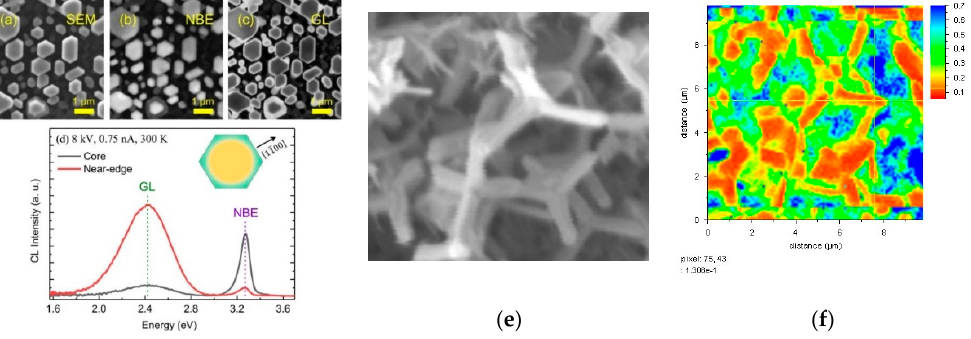
Figure 5. ZnO nanorod ( a ) SEI, region-of-interest ( b ) 3.32 eV NBE and ( c ) 2.46 eV GL intensity maps corresponding to the core and near-edge spectral features in ( d ). SEI of ZnO tetrapods ( e ) and corresponding HSI map ( f ) of NBE-normalized GL intensity extending 50–100 nm into the interior. With permission of John Wiley & Sons ( a – d ) [48] and Springer Nature ( e , f )